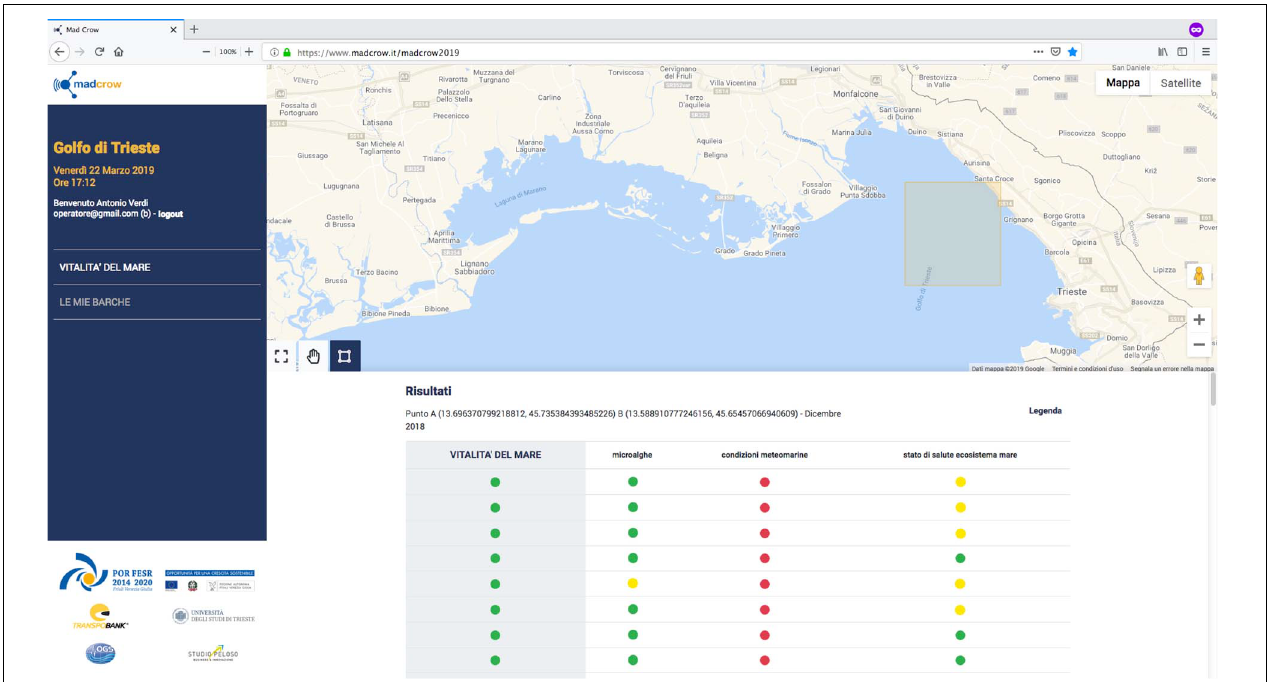
FIGURE 10 | DSS web portal. Here data acquired within the MaDCrow project is integrated with information from other sources. To make it understandable and respond to contextualization knowledge is represented using the metaphor of a semaphore.